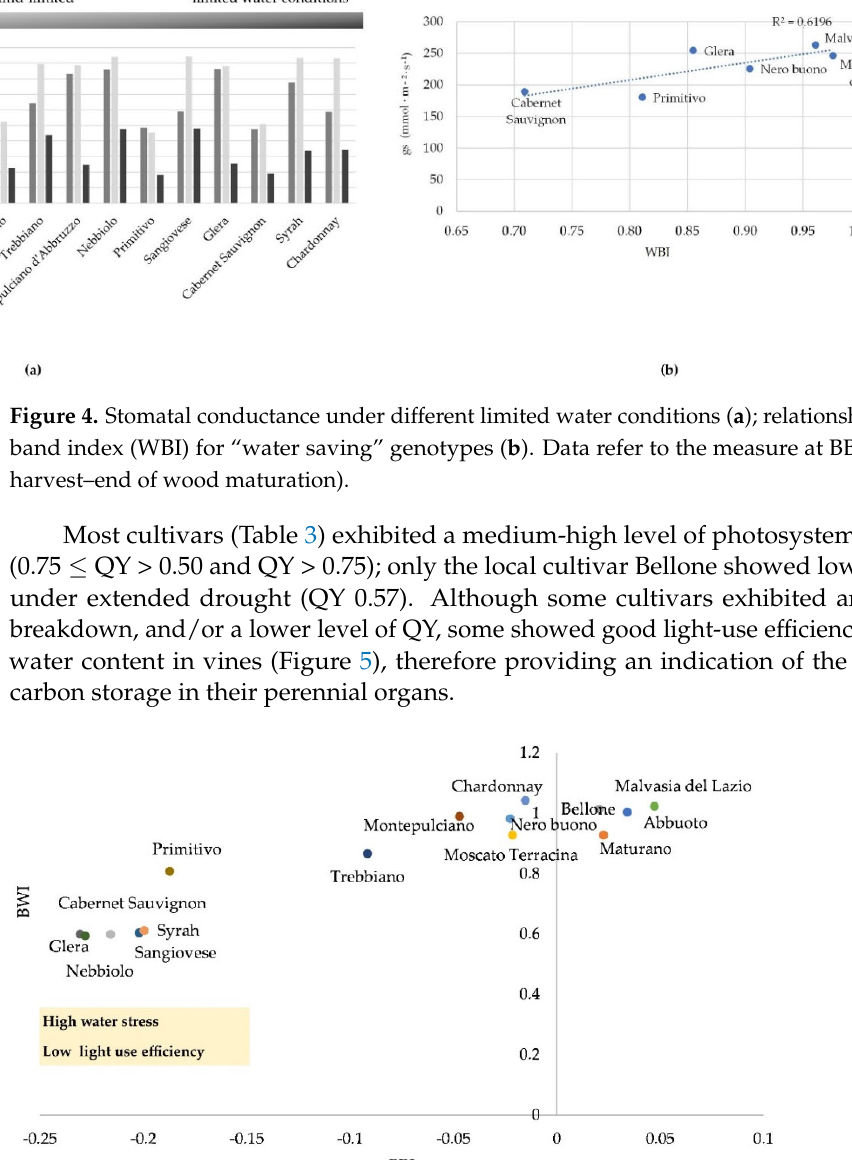
Figure 6. Hyperspectral signature of the tested cultivars. Measurements refer to the highest stress conditions, BBCH 089 (berries ripe for harvest).